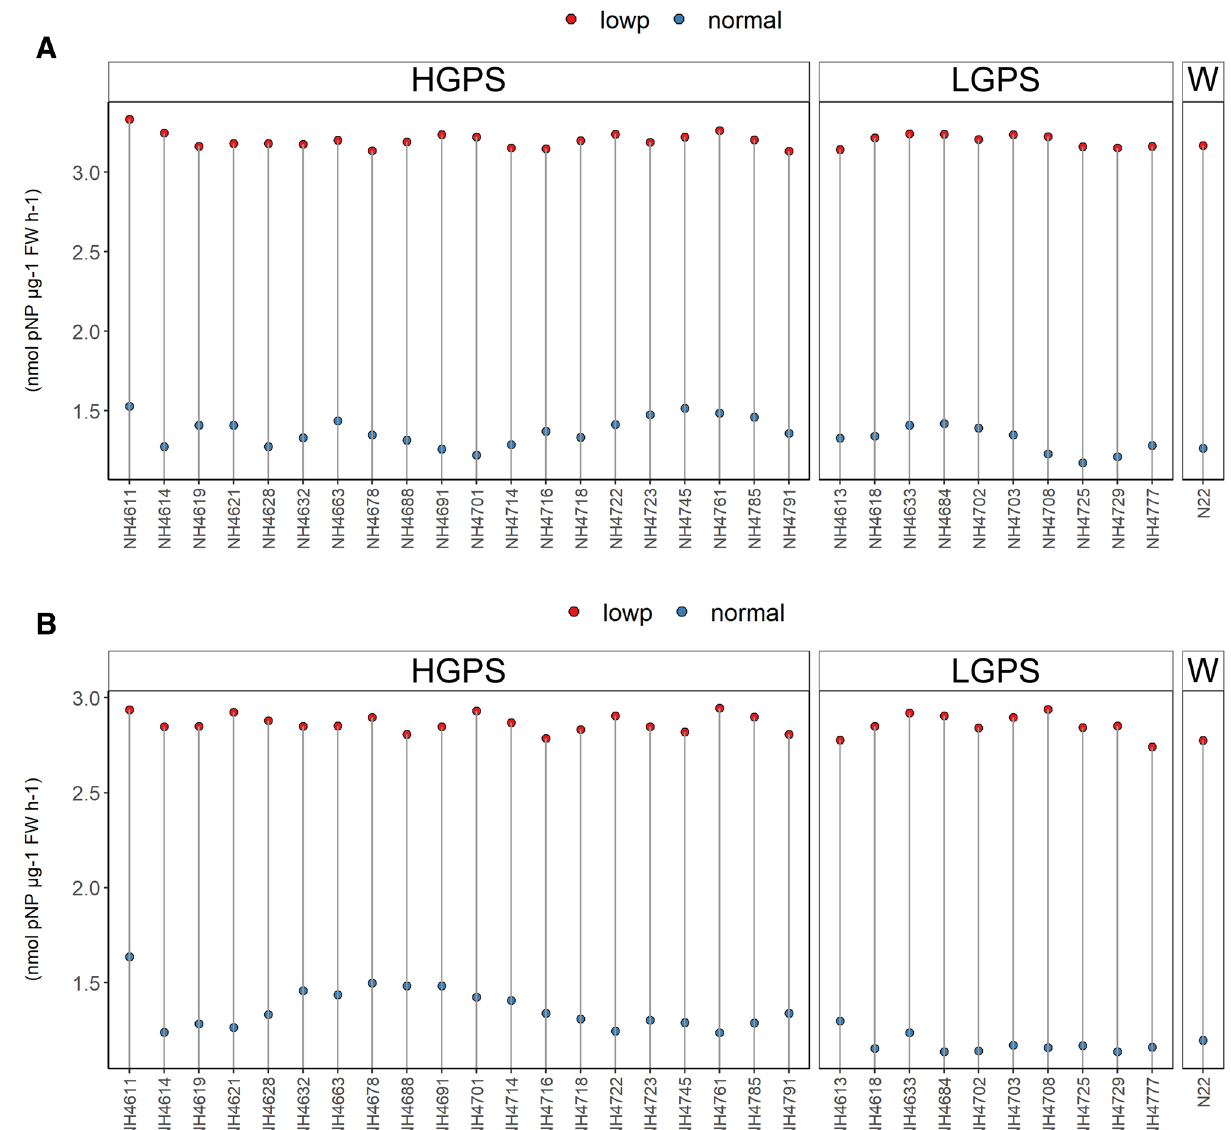
Figure 12. Externally secreted acid phosphatase (ESApase) enzyme activity of seedlings obtained from germination of seeds harvested from low P (shown as red dots) and normal P (shown as blue dots) fields. Wild type N22 (W), high grain P mutant seedlings (HGPS), and low grain P mutant seedlings (LGPS) were grown under normal P condition. ( A ) ESApase enzyme activity at 12 days of germination. ( B ) ESApase enzyme activity at 24 days of germination. The values represent the mean of 6